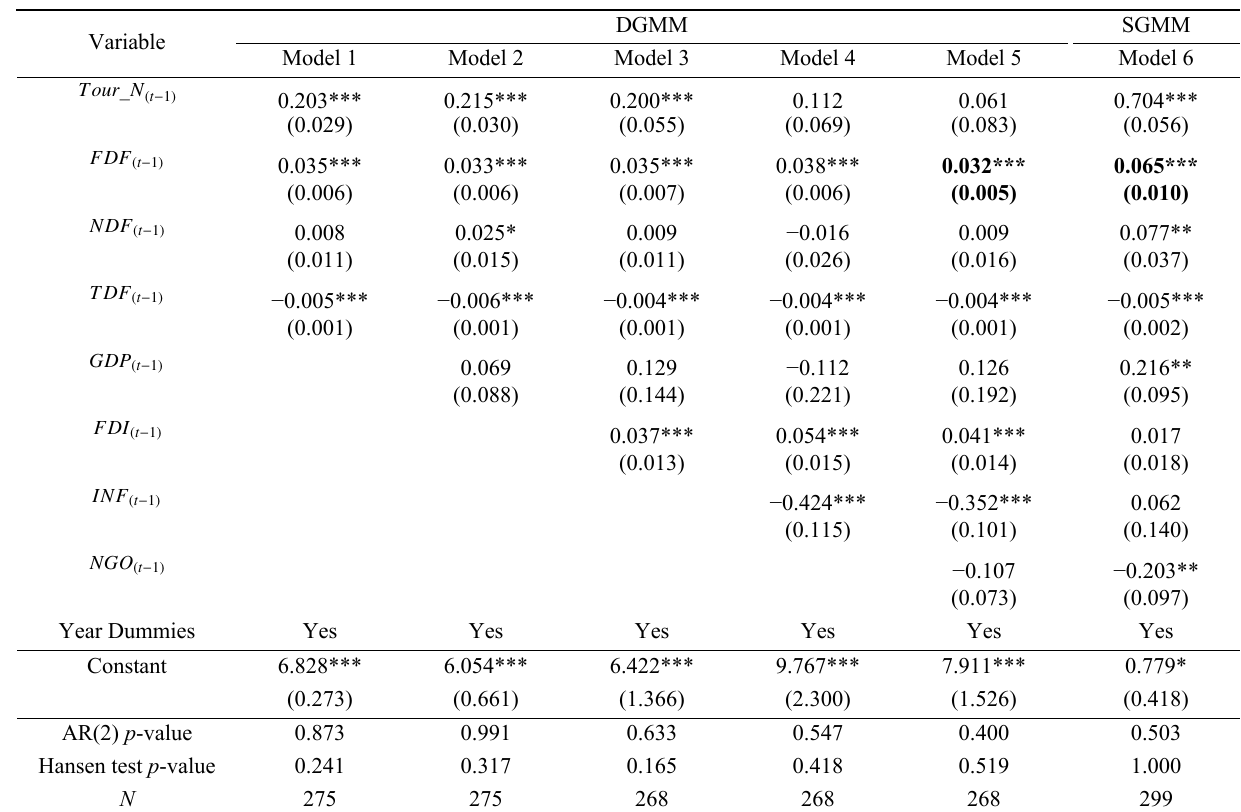
Table 3 Dynamic panel regressions of predicting the effect of literary destination familiarity on foreign exchange earnings from tourism